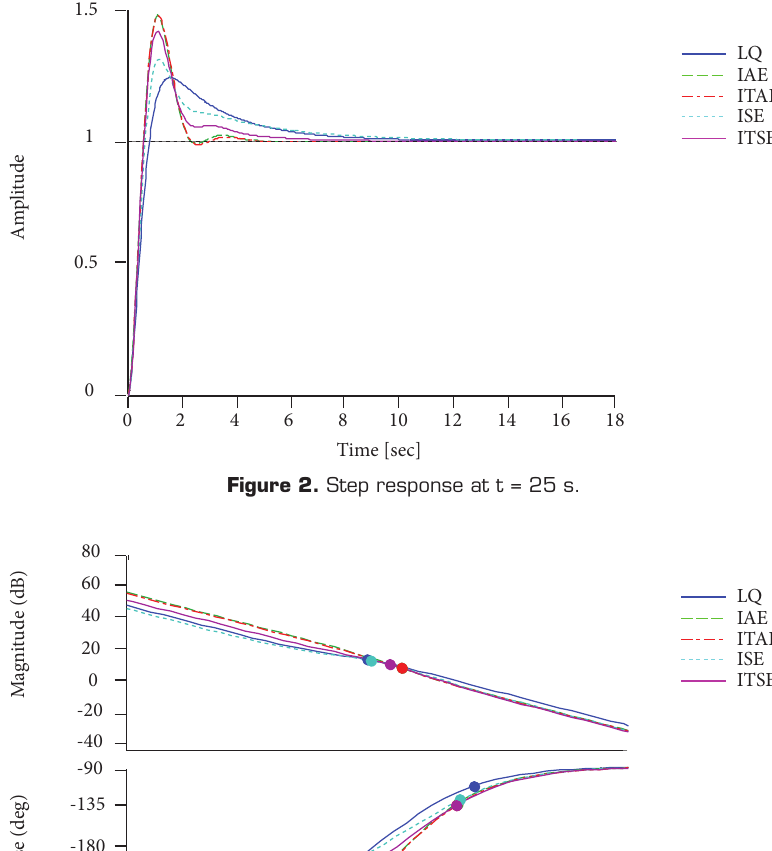
Figure 3. Frequency response at t = 25 s.